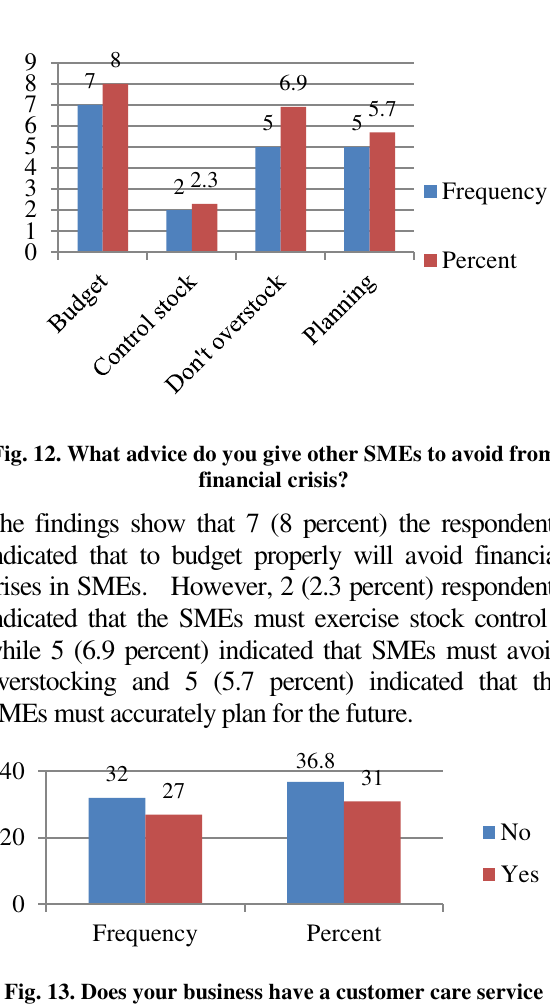
Fig. 13. Does your business have a customer care service hot-line?